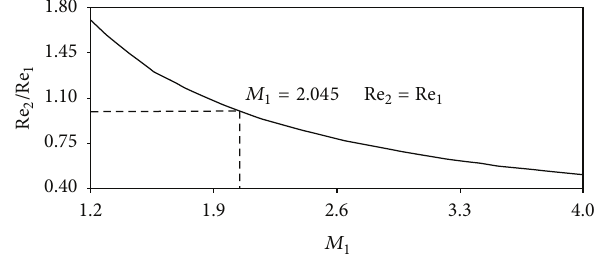
Figure 2: Upstream Mach number, 𝑀 1 , dependence of Re 2 / Re 1 . Note that, at 𝑀 1 ≈ 2 , Re 2 = Re 1 .